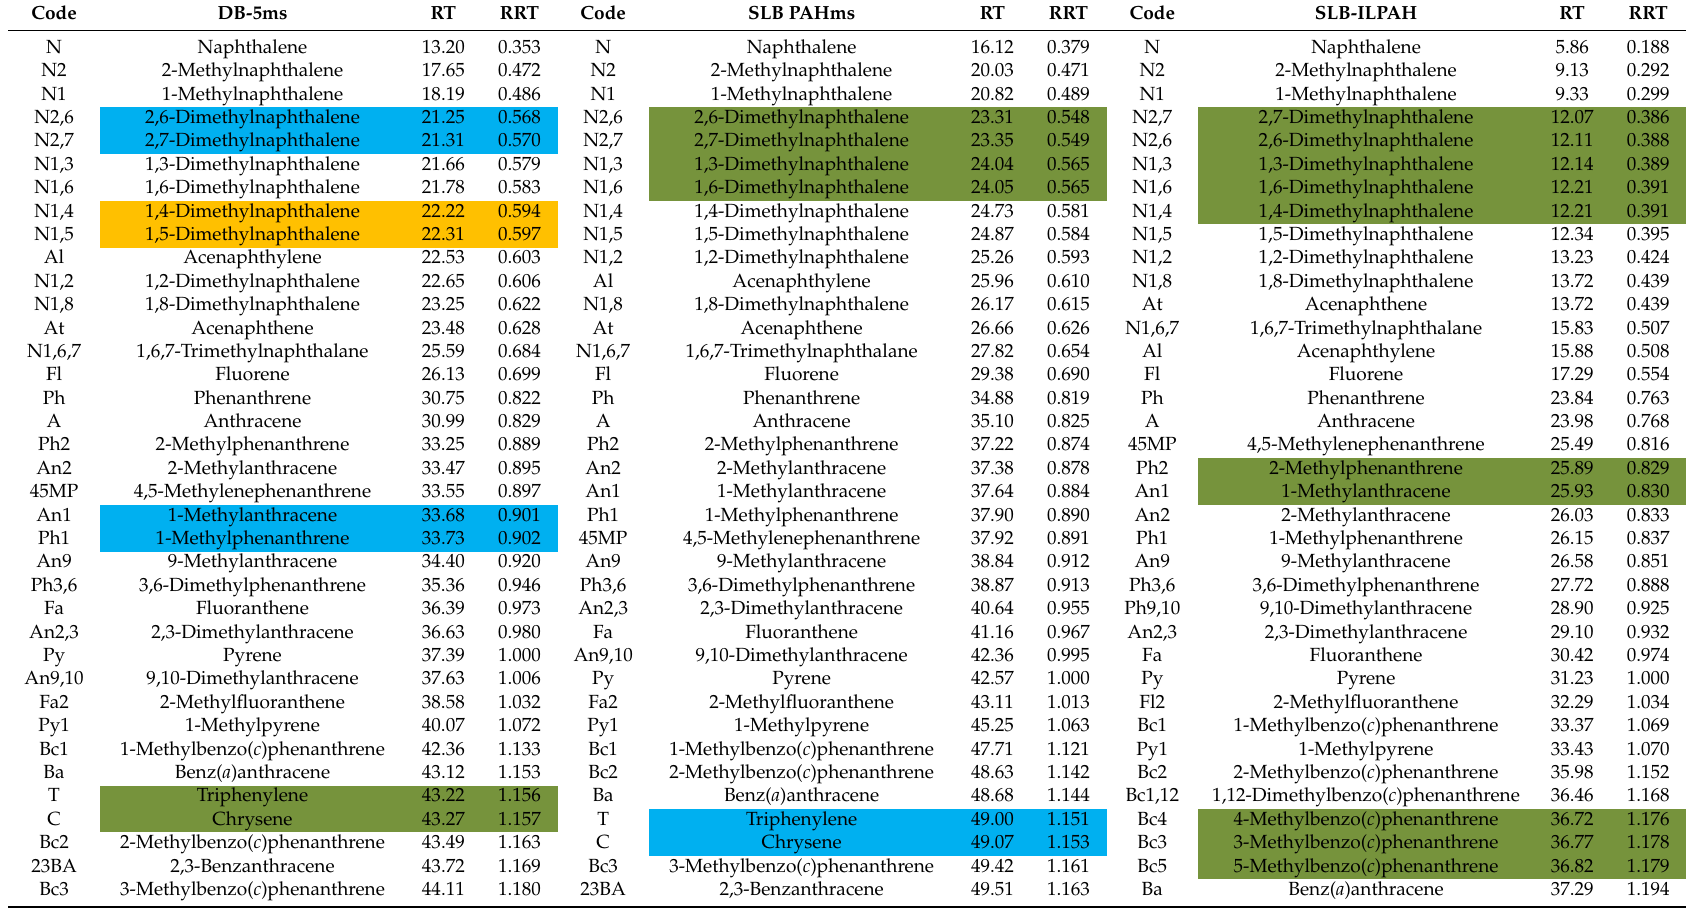
Table 2. PAHs and alkylated PAHs: retention times (RT) and relative retention times (RRT) in minutes. RRTs were calculated relative to pyrene. The coeluting isomers are marked: green (overlap > 90%), blue (90% < overlap > 50%) and orange (overlap <